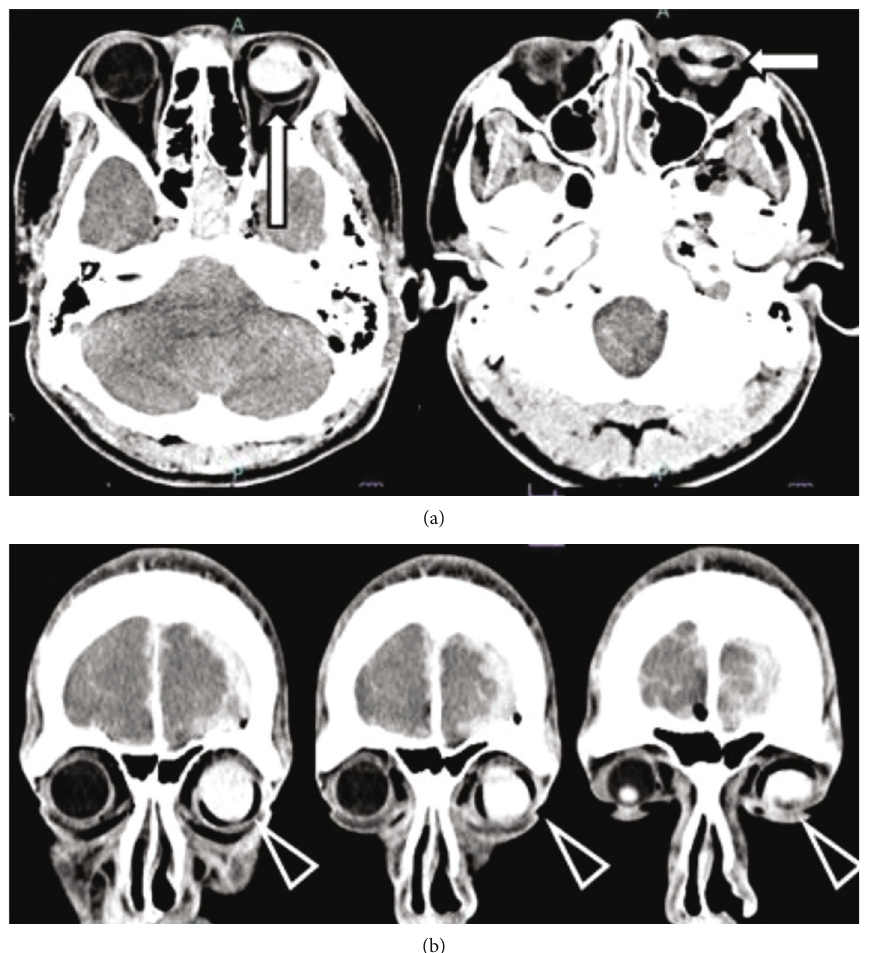
Figure 1: (a) Axial transverse CT and (b) coronal CT through the orbit. A low-density silicone rubber circling band (white arrow) and a well- de fi ned, homogenous, hyperdense mass (black arrowhead) seen in the cross section were observed in the left